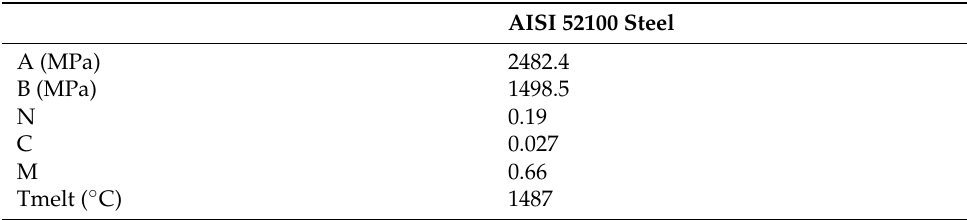
Table 7. The JC parameters of AISI 52100 bearing steel [77].